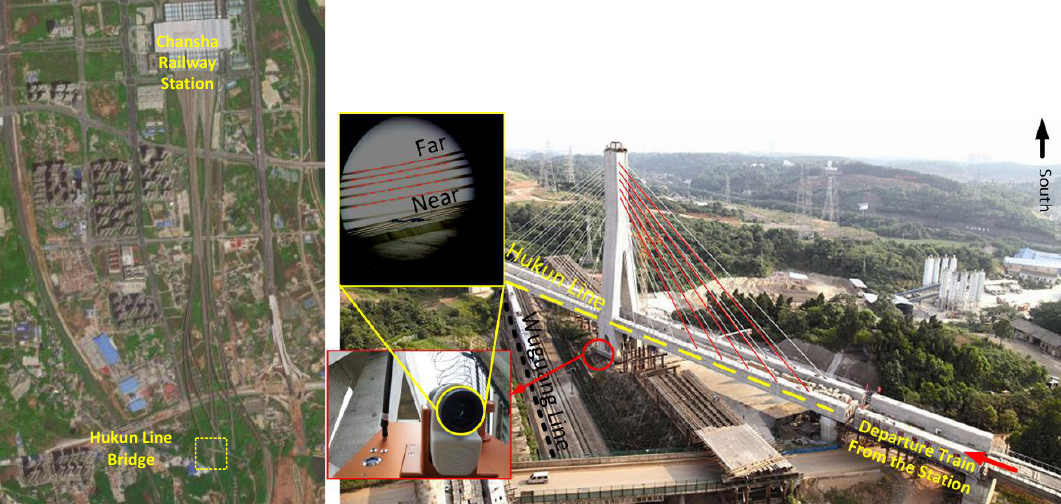
Table 2. Parameters of simulation and the K band interferometric radar.